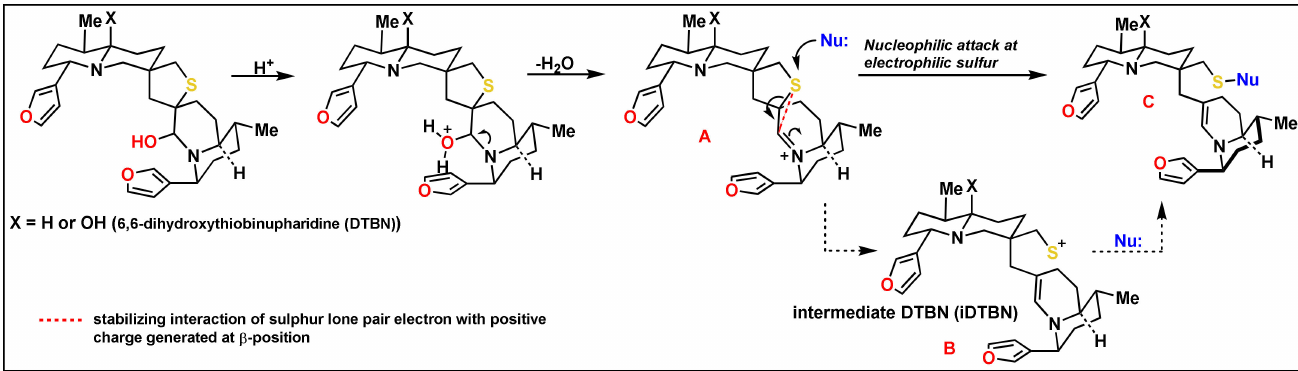
Figure 1. Hypothetical mechanism of interaction between the electrophilic sulfur of the nupharidine and a nucleophilic cysteine sulphur at the active site of the cysteine protease